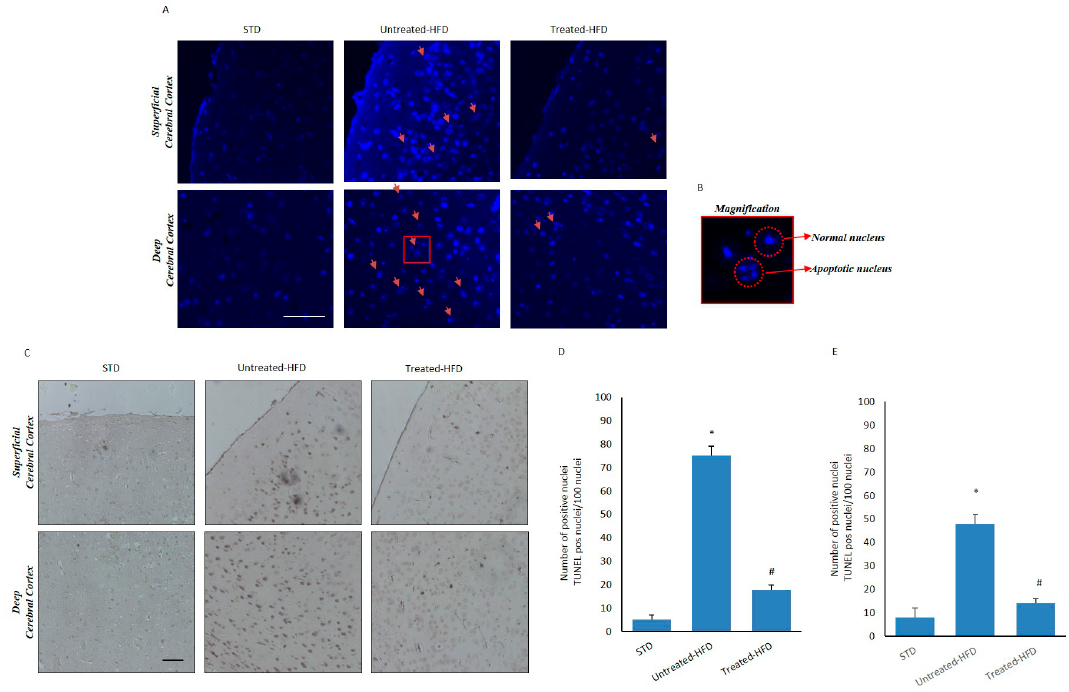
Figure 6. NDS inhibits neurodegeneration induced by HFD. ( A ) Brain sections from STD, untreated- HFD and treated-HFD mice incubated with Hoechst 33342. Fragmented apoptotic nuclei are indicated by the arrows; ( B ) The outlined area is enlarged in the squares; ( C ) TUNEL assay on superficial and deep cortical regions from STD, untreated-HFD and treated-HFD mice; ( D ) Number of apoptotic nuclei in the superficial cerebral cortex positive area; ( E ) Number of apoptotic nuclei in the deep cerebral cortex positive area. Representative images from 3 animals per group are shown. Bar 20 μ m. Data are the mean values ± SD ( n = 8/group). * p ≤ 0.05 vs. STD. # p ≤ 0.05 vs. untreated-HFD.